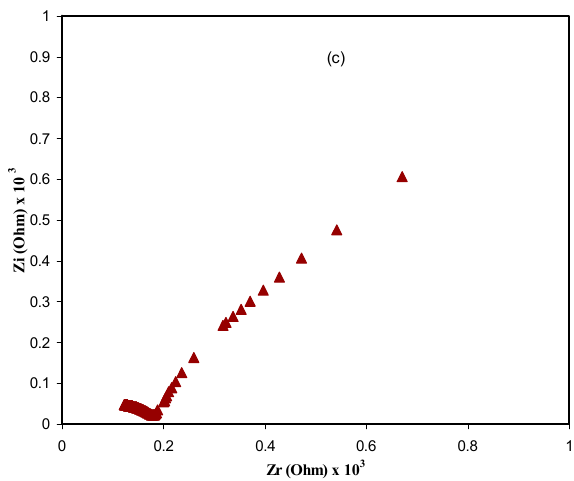
Figure 3. Electrical impedance plots for CS: POZ: MgTf solid polymer blend electrolyte film at ( a ) 303 K, ( b ) 323 K, and ( c ) 343 K.